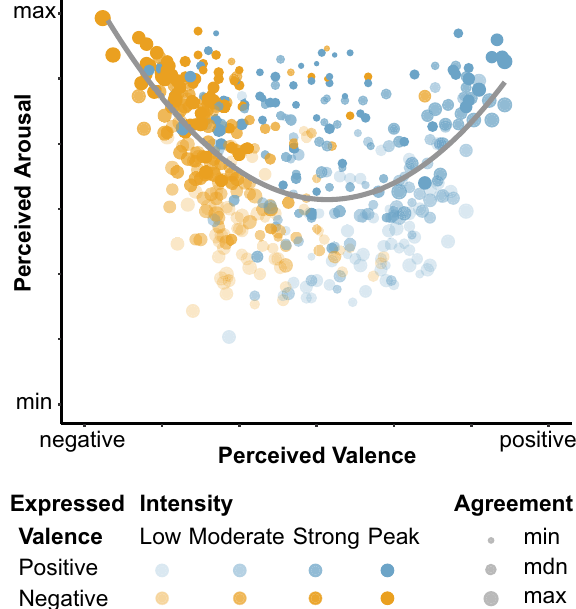
Figure 4. Two-dimensional space of perceived valence and arousal. Stimuli are represented by individual dots of different color (expressed valence) and transparency (expressed intensity). The boomerang-shaped distribution of valence and arousal ratings (Expt. 3) is described by their significant quadratic relationship (gray line). Dot size indicates participant agreement on valence ratings. Figure created with R version 4.0.3 35